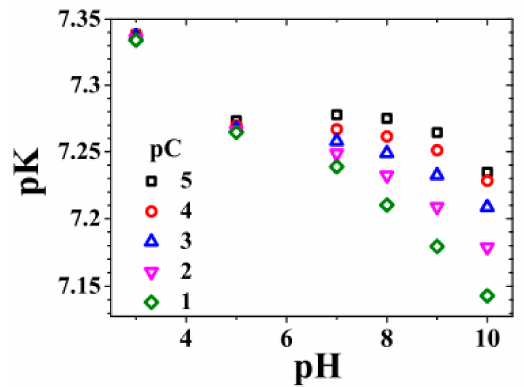
Figure 4. The pK values obtained from the definition of the equilibrium constant of the reaction SiO − + H + ⇔ SiOH . The energy height of the potential trap used is γ = 510 mV. Adapted from